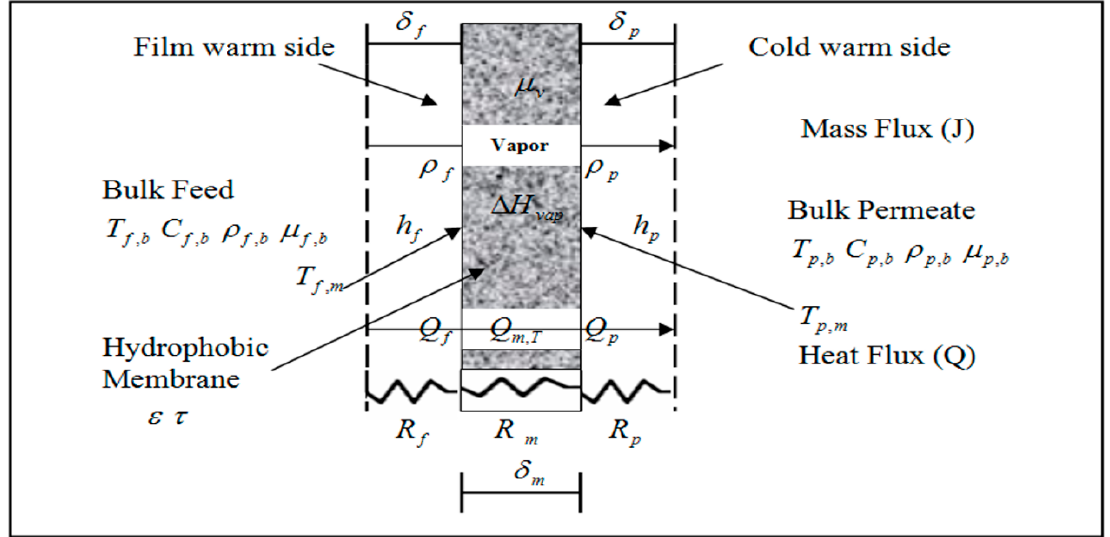
Figure 1. Heat and mass transfer profiles in membrane distillation.